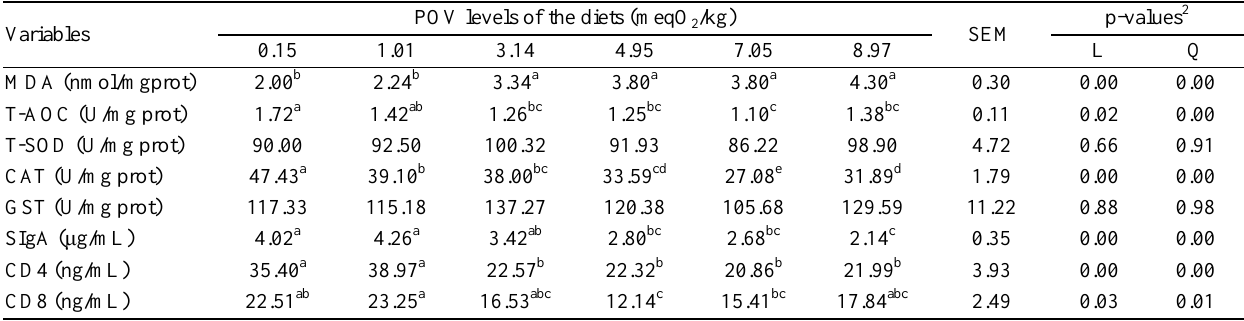
POV levels of the diets (meqO 2 /kg)